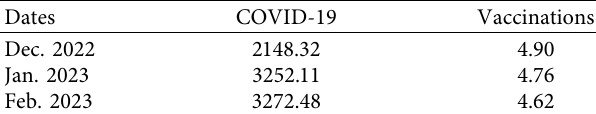
Table 3: Prediction of relevant variables.